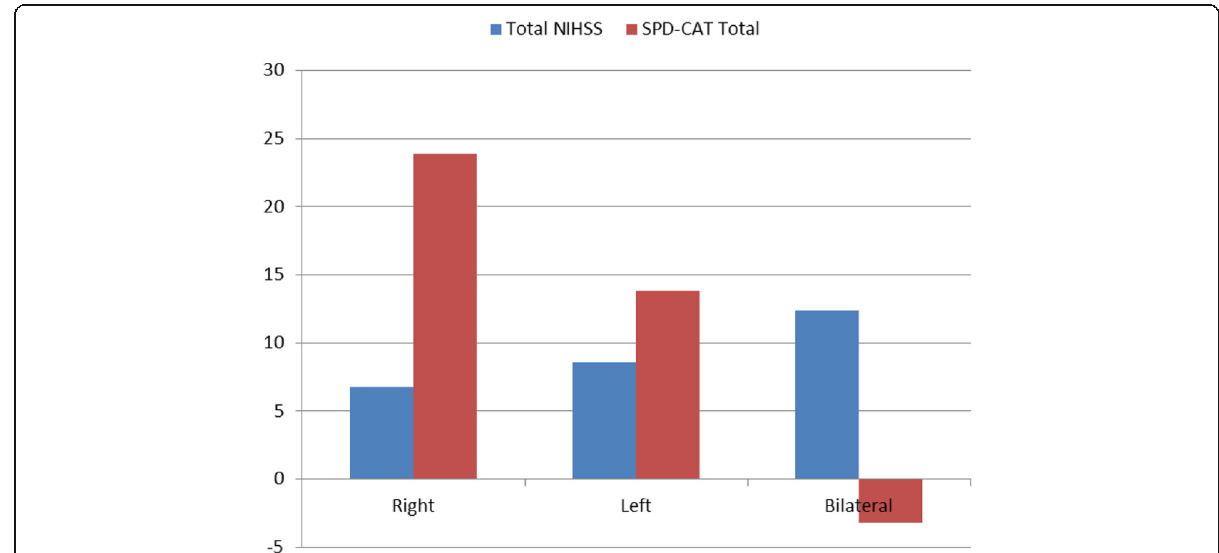
Fig. 5 Correlation between Total NIHSS, SPD-CAT, and lesion side of stroke